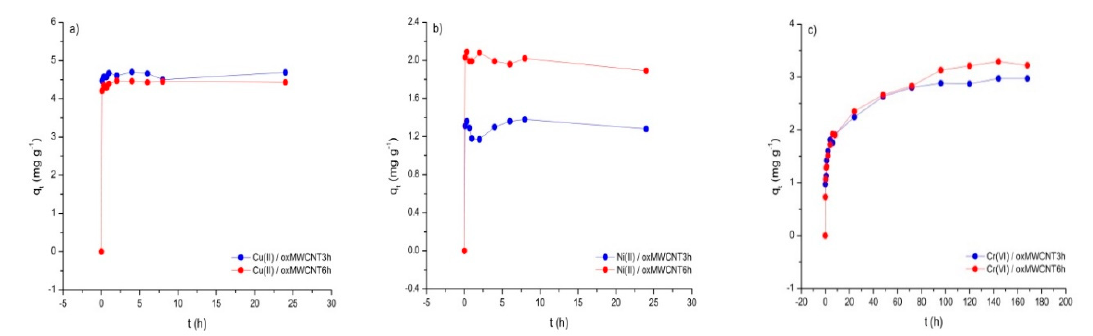
Figure 3. Adsorption of: ( a ) Cu(II), ( b ) Ni(II) and ( c ) Cr(VI) on oxMWCNT3h and oxMWCNT6h as a function of contact time ( m = 5 mg, V = 30 mL (0.1 M NaNO 3 ), C 0 = 1 mg L − 1 , pH = 5 ± 0.1 (Cu(II) and Ni(II)) and 2.5 ± 0.1 (Cr(VI)), t = 5 min-24 h (Cu(II) and Ni(II)) and 5 min-168 h (Cr(VI)), agitation speed